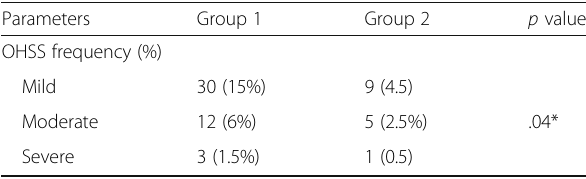
Table 3 Comparison of different ICSI outcomes in both groups Parameters Group 1